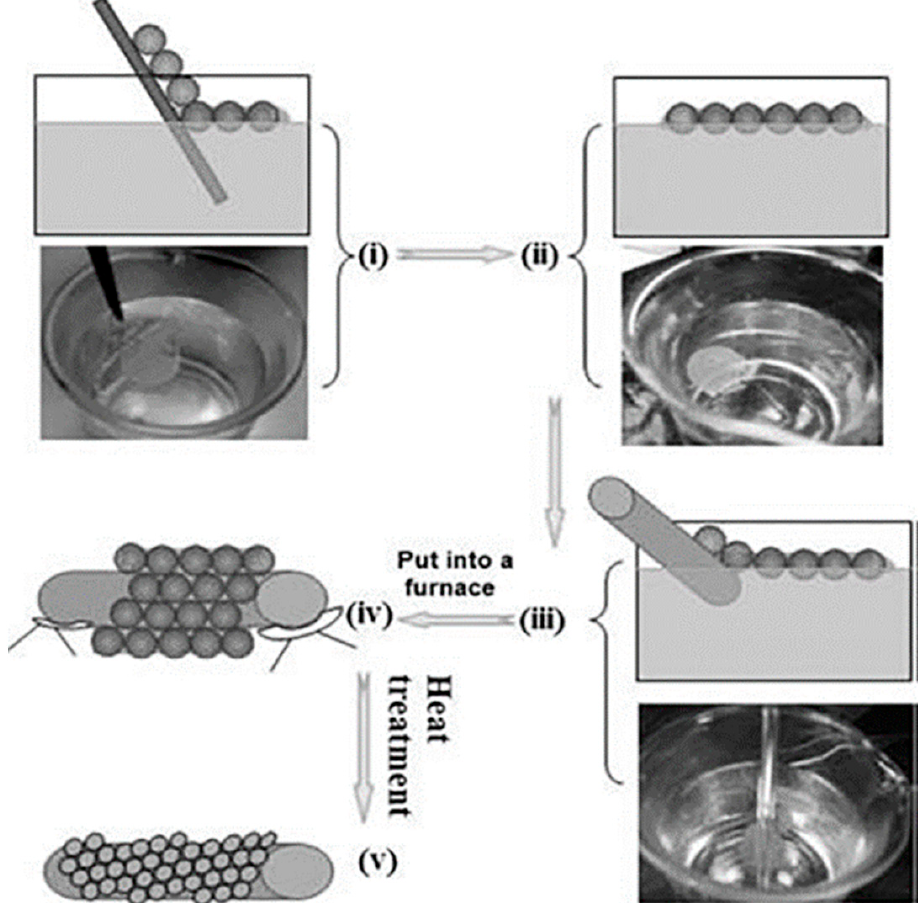
Figure 23. ( i ) Glass plate covered with PS colloid immersed in the solution. ( ii ) Monolayer of colloid floating on the surface of the solution. ( iii ) Pick up with glass rod. ( iv ) Drying. ( v ) Calcination to remove the PS microspheres [90]. Figure 24. First, the single-layer polystyrene microspheres are put into the SnCl 4 solution. Due to surface tension, polystyrene microspheres were suspended on the surface of SnCl 4 . Then, an interdigital electrode was used for fishing out the polystyrene microspheres. Finally, the polystyrene microspheres were removed by heating the interdigital electrode to 400 ◦ C in air and calcining for 2 h. Both double-layer and triple-layer SnO 2 films can be manufactured using polystyrene microsphere templates